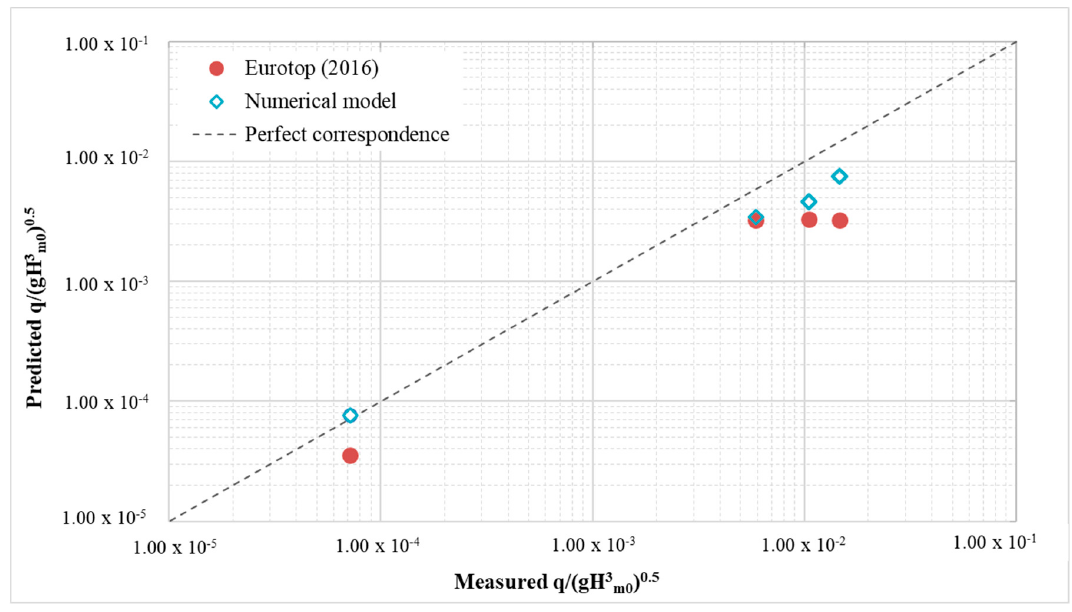
Figure 6. The numerical and theoretical vs. laboratory q* reservoir for the normal wave conditions.